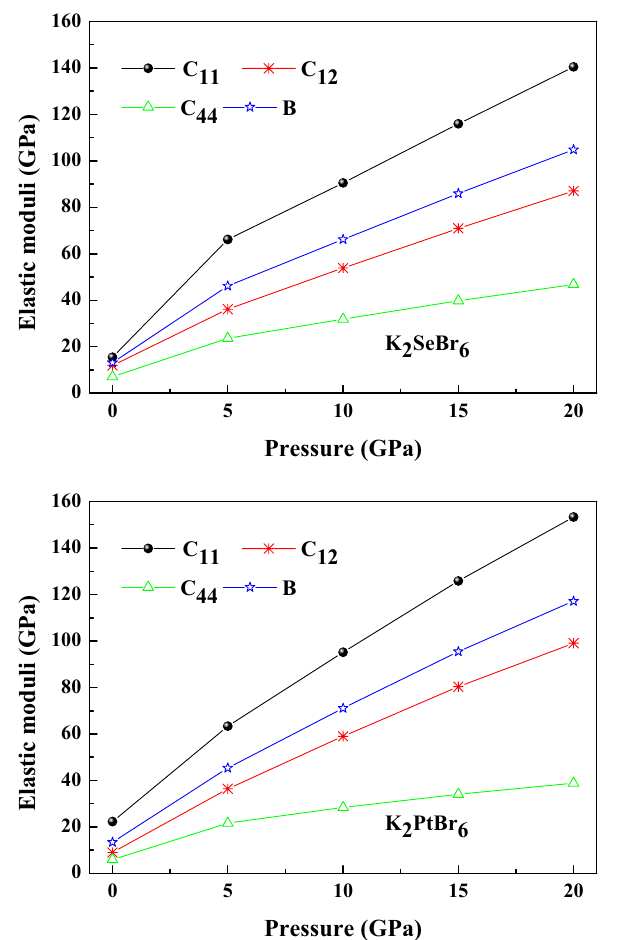
Figure 5. Elastic moduli of K 2 SeBr 6 and K 2 PtBr 6 .